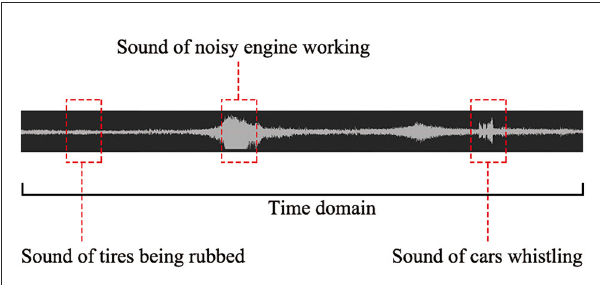
FIGURE2 A waveform graph of traffic sounds over time